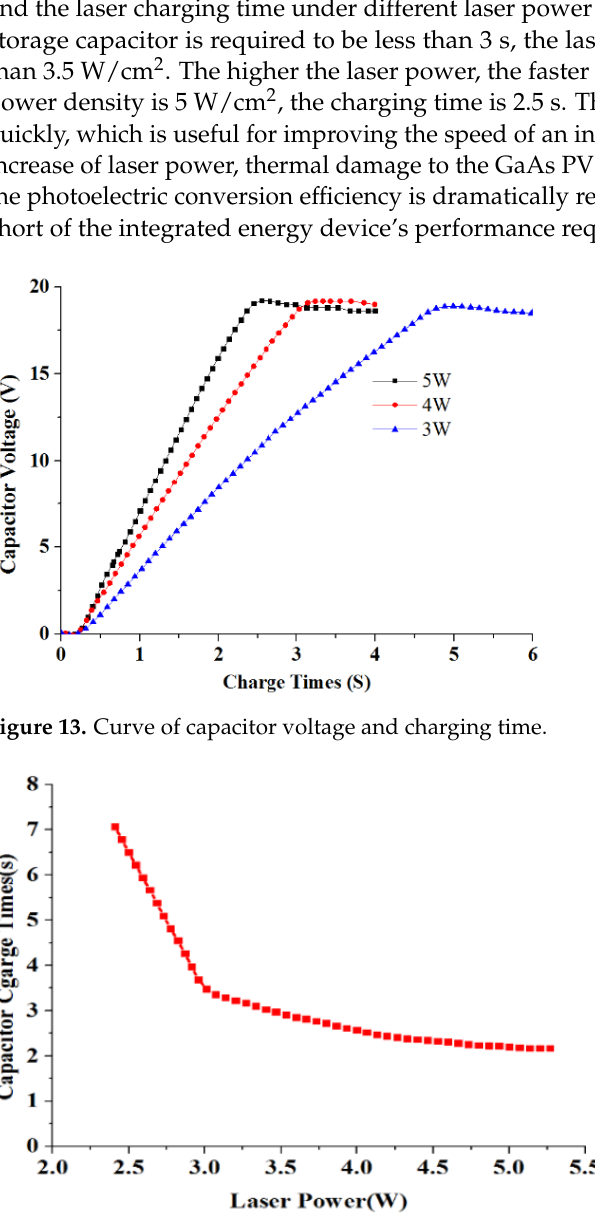
Figure 12. Safe-and-arm control-integrated circuit. ( a ) Module composition. ( b ) Integrated circuit prototype.